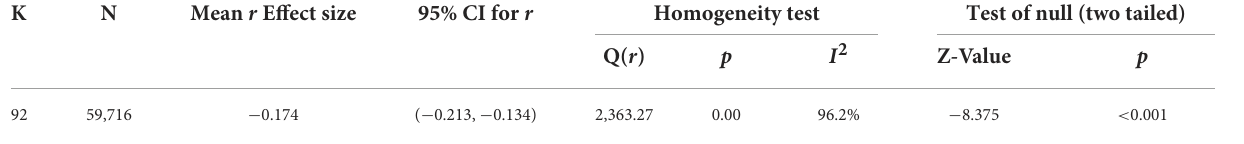
TABLE 3 Random-model of the correlation between MPA and social support. K N Mean r Effect size 95% CI for r Homogeneity test Test of null (two tailed) Q( r